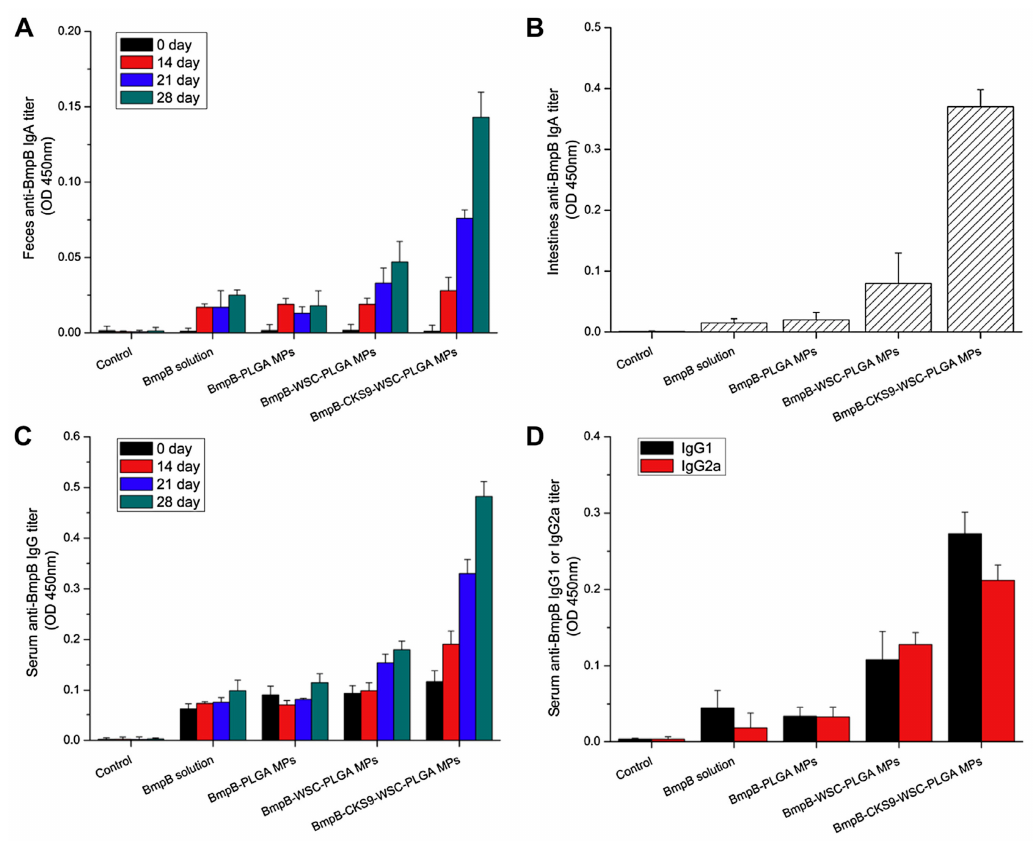
Figure 14. BmpB-specific immune response after oral administration. Anti-BmpB IgA levels in feces ( A ) and intestine ( B ), anti-BmpB IgG levels in serum ( C ) and anti-BmpB IgG subclass antibody (IgG1 and IgG2a) ( D ) levels were measured using ELISA [53].